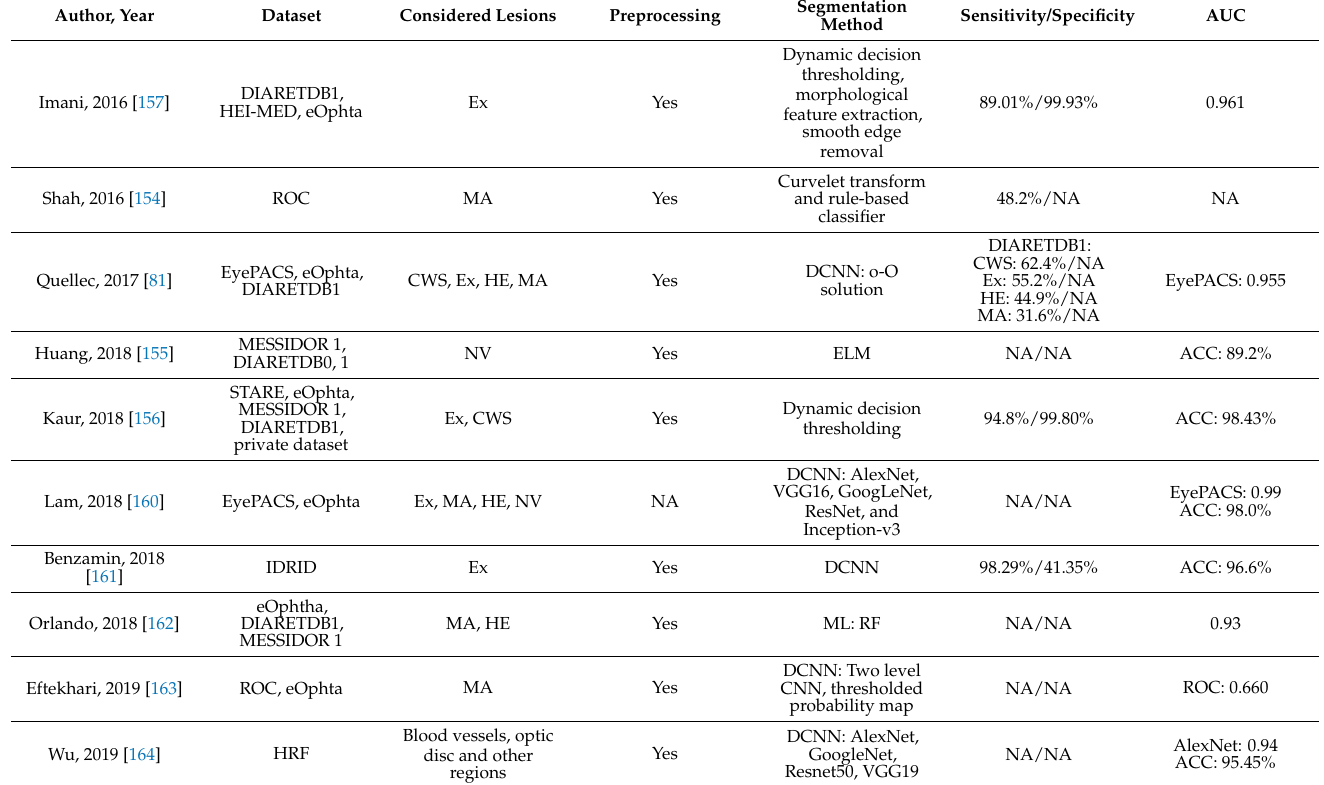
Table 5. Segmentation-based studies in DR detection using fundus